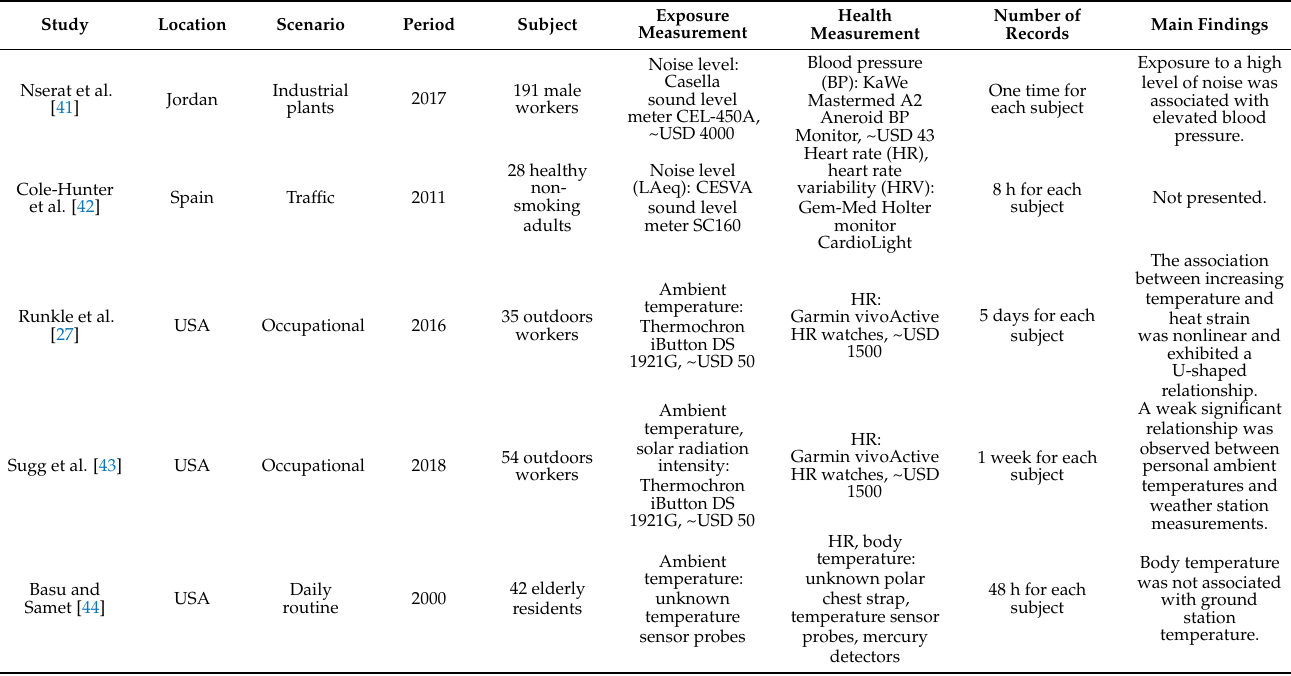
Table 1. Studies focusing on health effects of physical factor exposure.